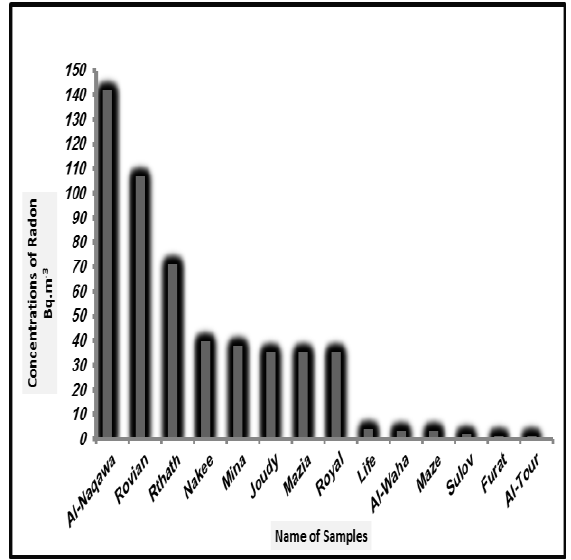
Fig. (2) Concentration of radon in healthy drinking water samples.